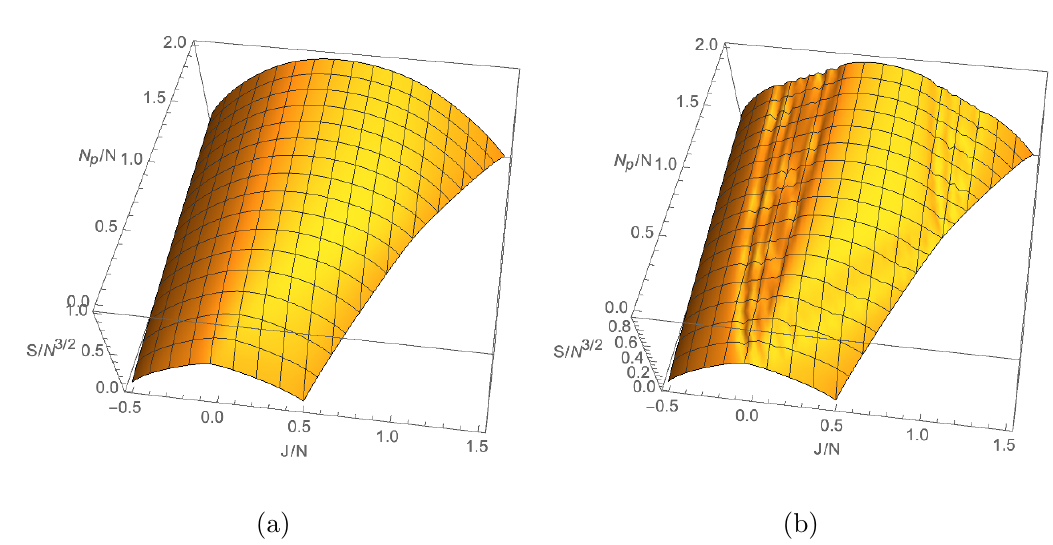
Figure 9 . The plot of the growth of the coe(cid:14)cients of (a) supergraviton partition function and (b) supergraviton elliptic genus for K3 computed numerically for N = 16. What is plot- ted is S (cid:17) log j c ( N; N p ; J ) j where we expand partition function and elliptic genus as Z N = P c ( N; N p ; J ) q N p y J N p ;J